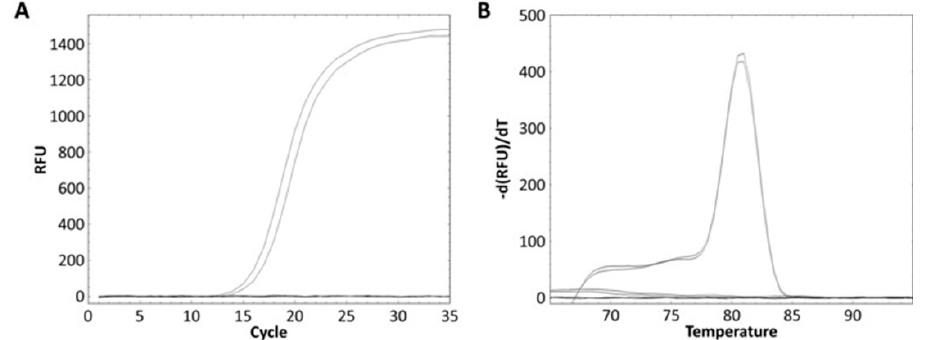
Figure 5. Evaluation of real-time PCR method against 61 bacterial strains. ( A ) All strains except L. zeae KACC 11461 and LI220 showed no amplified and ( B ) only these products obtained melting curves. Table 4. Comparison of 16S rRNA gene sequencing and real-time PCR.